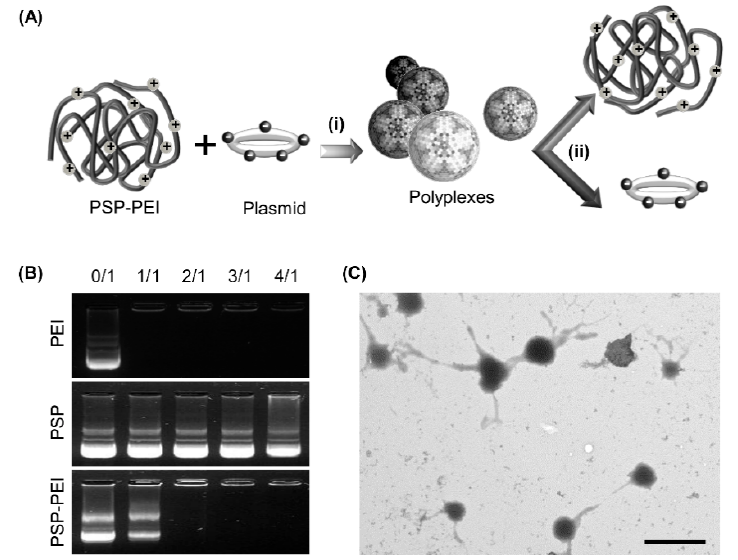
Figure 2. ( A ) Schematic diagram showing (i) the formation of polyplexes via electrostatic interactions between DNA and PSP-PEI, and (ii) the subsequent dissociation process undertaken by the polyplexes after cellular internalization. ( B ) Gel retardation assay of polyplexes prepared with different polymers (PEI 25kDa, PSP and PSP-PEI) at various polymer/DNA mass-to-mass ratios: 0/1, 1/1, 2/1, 3/1, and 4/1. ( C ) A representative TEM micrograph of polyplexes formed between PSP-PEI and DNA. The scale bar is 1 μ m.